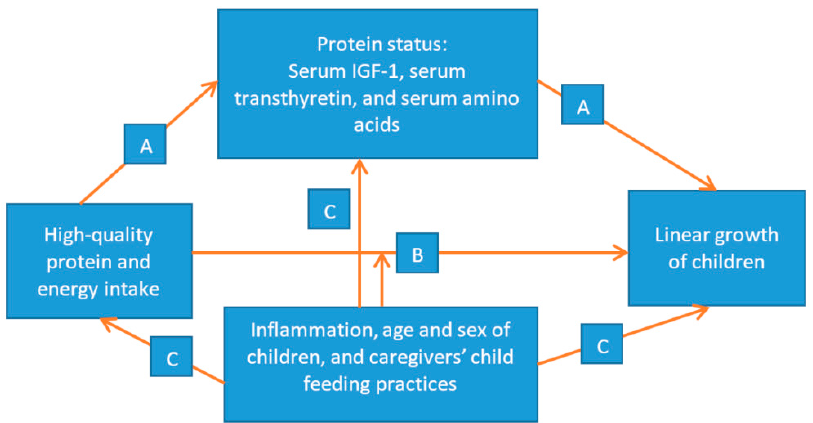
Figure 1. Conceptual framework depicting pathways for associations between protein and energy intakes and linear growth of children: (A) Intake of high-quality protein improves protein status [12], which in turn improves the linear growth of children; (B) The relationship between high-quality protein and energy intakes and linear growth of children is affected by inflammation [6]; and (C) Inflammation, together with characteristics of the child and caregivers’ child feeding practices, reduces nutrient (protein and energy) intake, biomarkers of protein status, and linear growth of children [12].